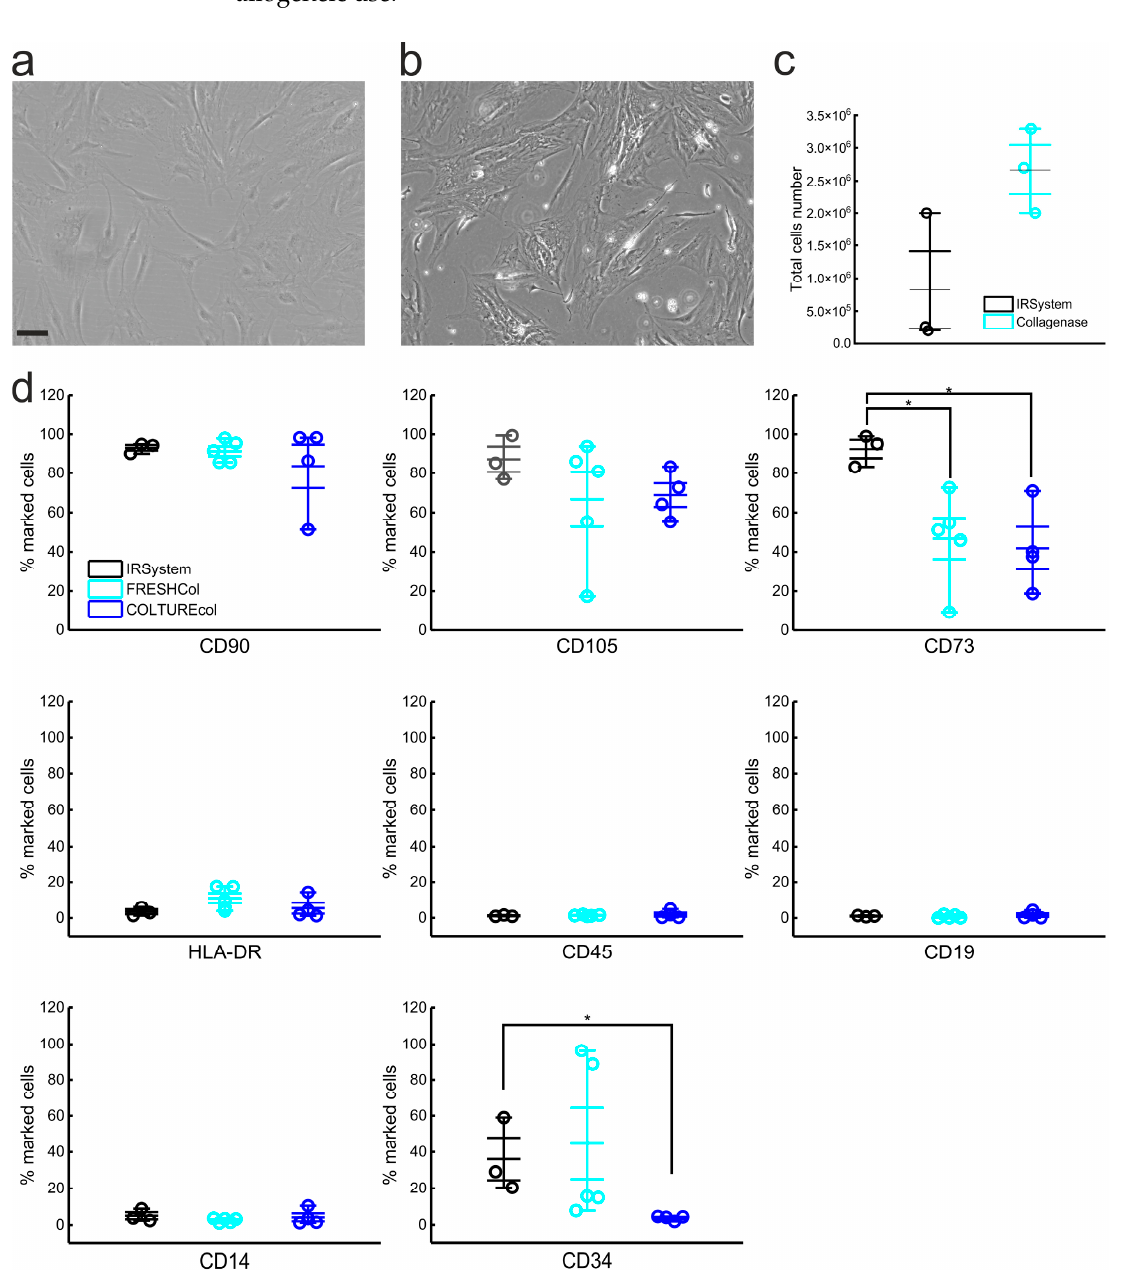
Figure 5. The cellular fraction isolated from lipoaspirates using IStemRewind contains CD73 + and CD34 + MSCs. ( a , b ) Representative bright field images of cells extracted with IStemRewind ( a ) or by collagenase digestion ( b ) from lipoaspirates. Scale bar, 100 µ m. ( c ) Box plots of total cell counts determined by flow cytometry in cellular materials obtained from lipoaspirates processed as indicated ( n = 3). ( d ) Box plots of the percentage of cells stained by the surface markers determined by flow cytometry in cells extracted using the indicated methods from lipoaspirates ( n = 4). * p < 0.05 in a Kruskal–Wallis ANOVA among the indicated